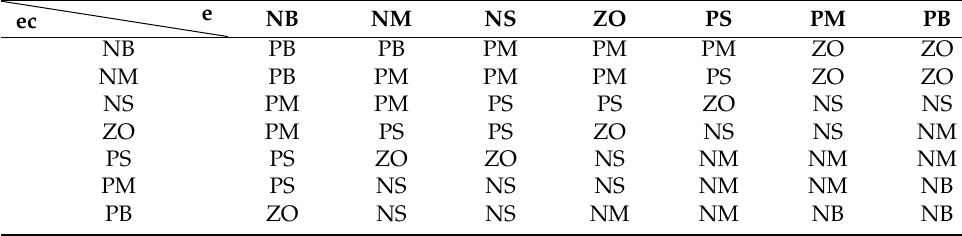
Table 3. Proportion (P) fuzzy rule table.